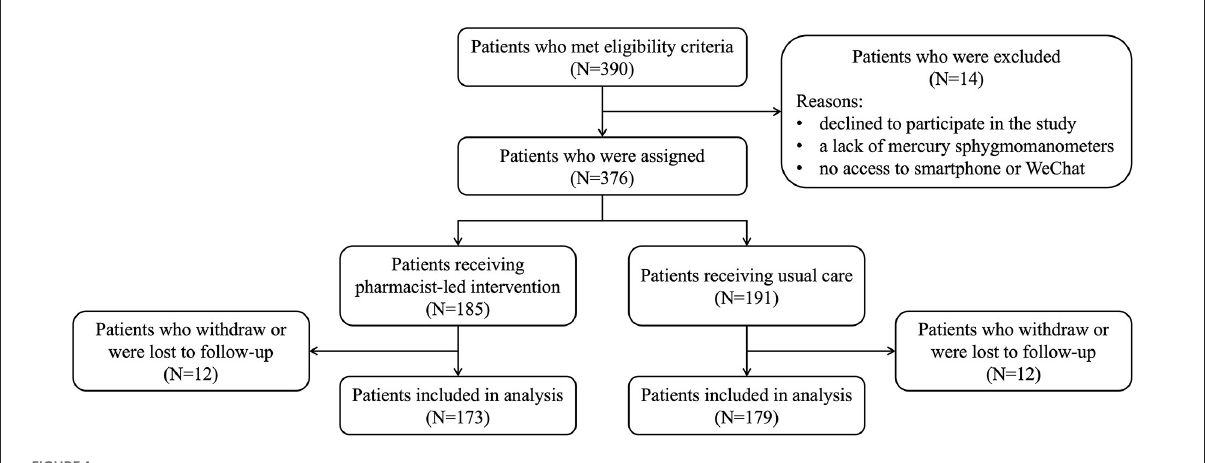
FIGURE1 The flowchart of study screen and